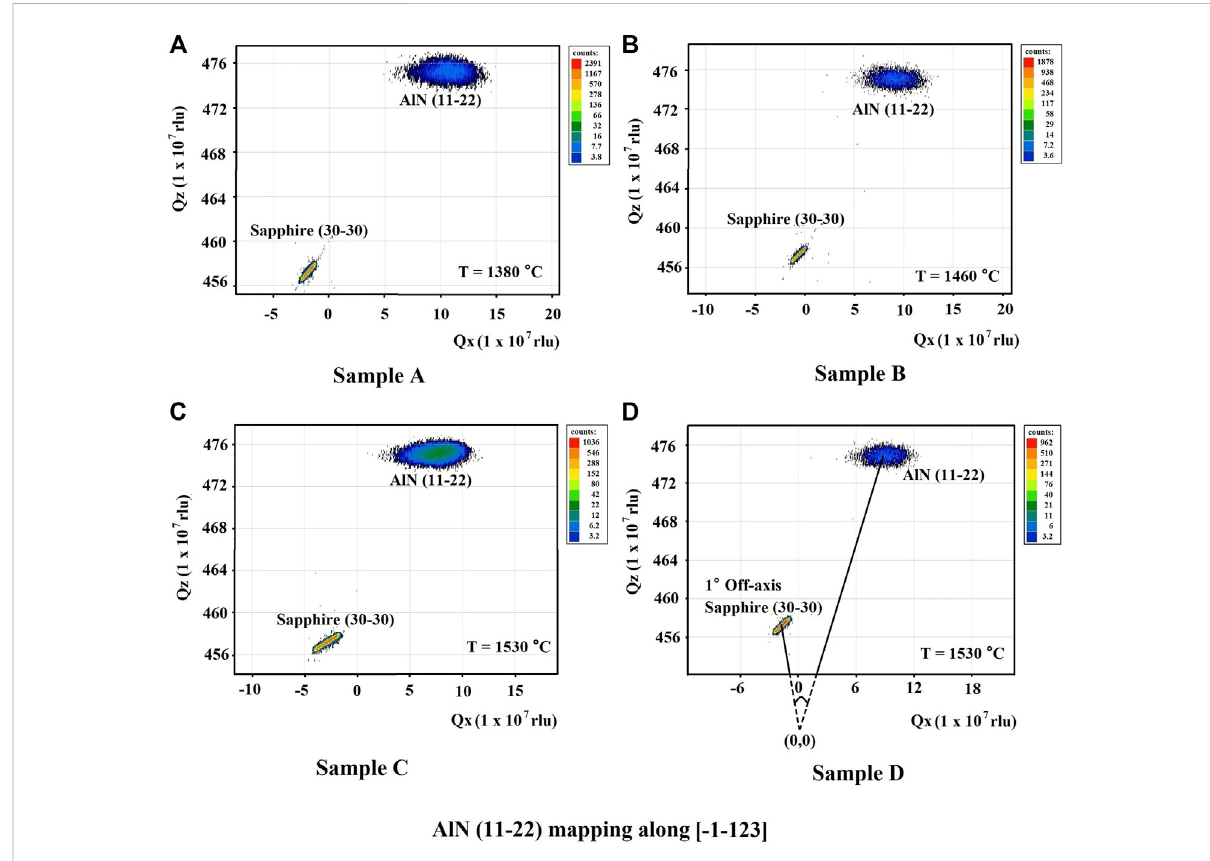
FIGURE 4 X-ray reciprocal space mappings along [ − 1 − 123] AlN for (A) Sample A, (B) Sample B, (C) Sample C, and (D) Sample D.